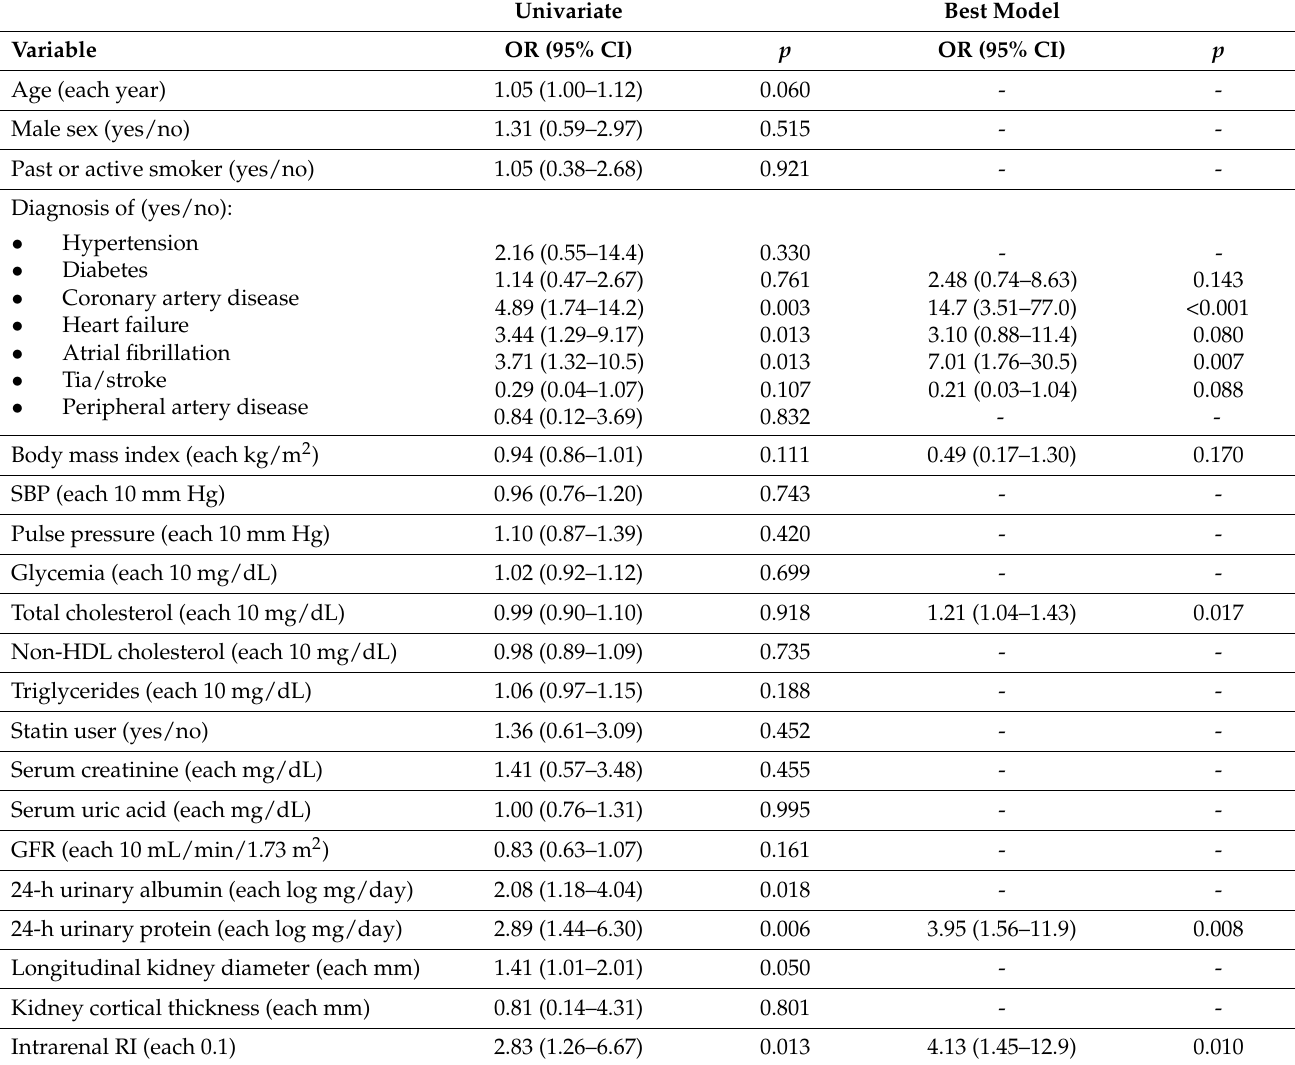
Table 4. Univariate and best logistic regression model for renal disease progression assessed by at least 0.5 mg/dL increment of creatinine levels during 5-year follow-up. Univariate Best